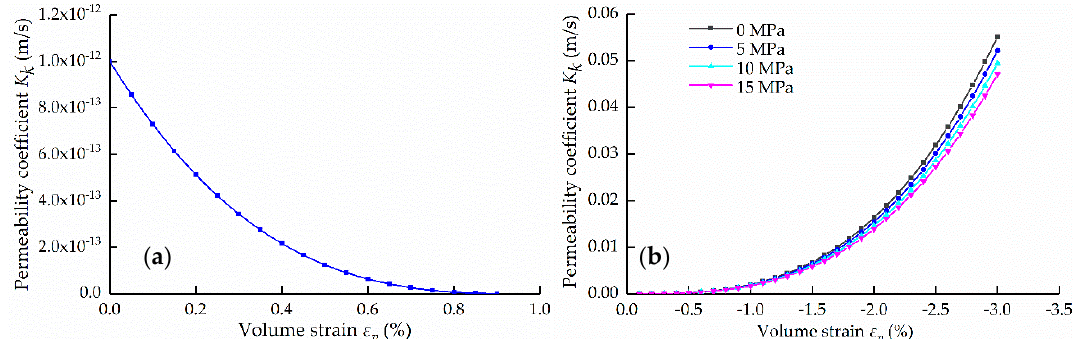
Figure 9. The evolution curves of infiltration characteristic. ( a ) Case 1: ε v > 0; ( b ) Case 2: ε v < 0.